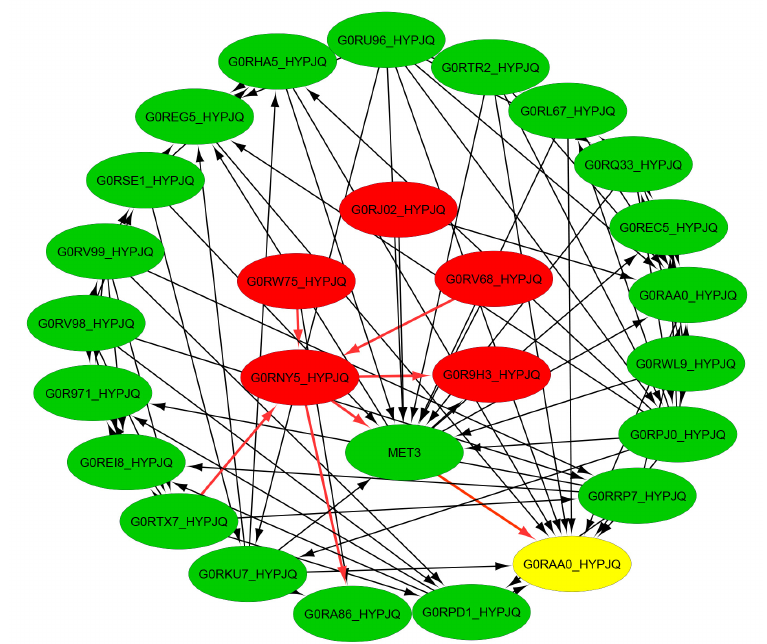
Figure 3. Constructed gene network of cyanide hydratase and some related genes using STRING and Cytoscape 3.7. The red genes symbolize the central network of proteins, while the yellow gene symbolizes the cyanide hydratase encoding